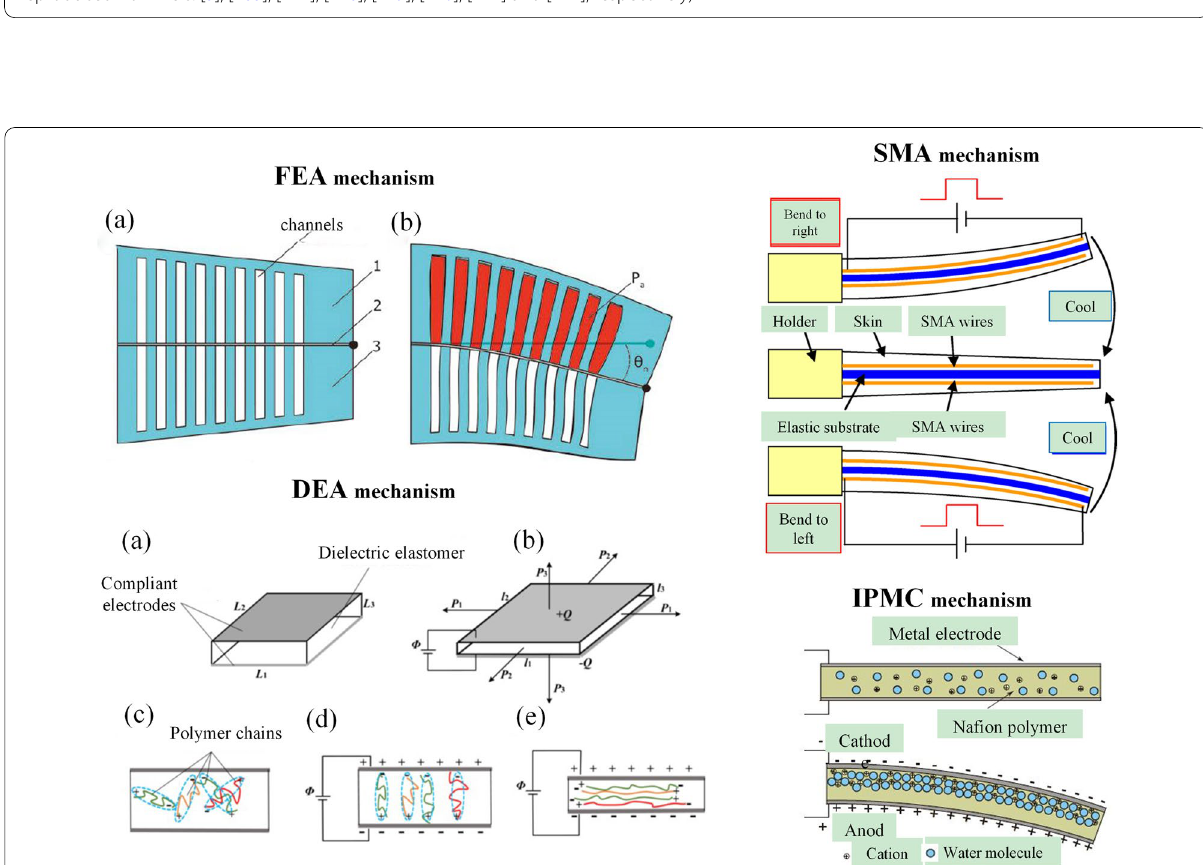
Figure 10 Soft actuator mechanisms (The figures of FEA mechanism, SMA mechanism, DEA mechanism and IPMC mechanism are reproduced from Refs. [10, 222, 225] and [219]